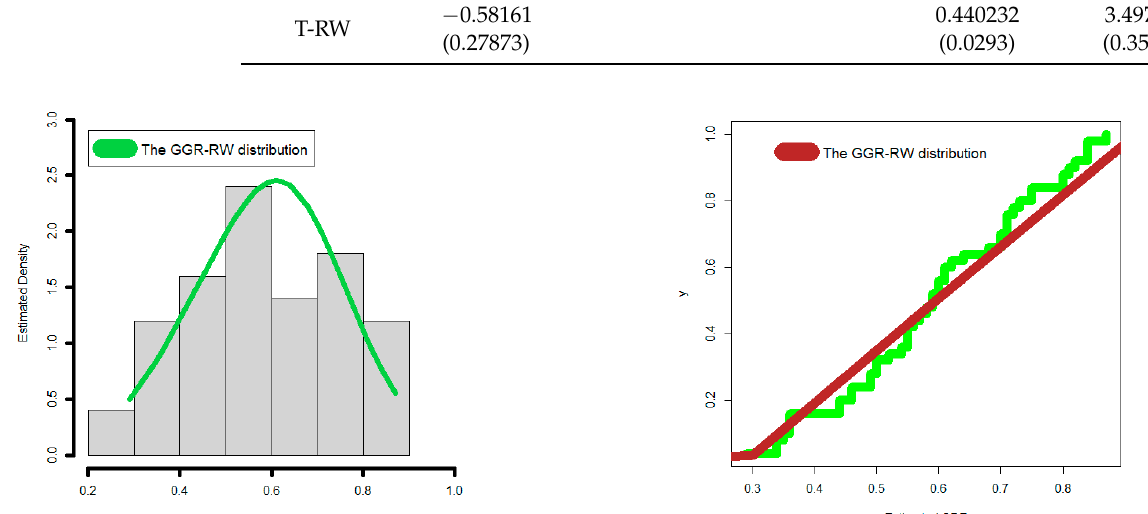
Figure 8. Estimated PDF (left) and estimated CDF (right) for the relief times.